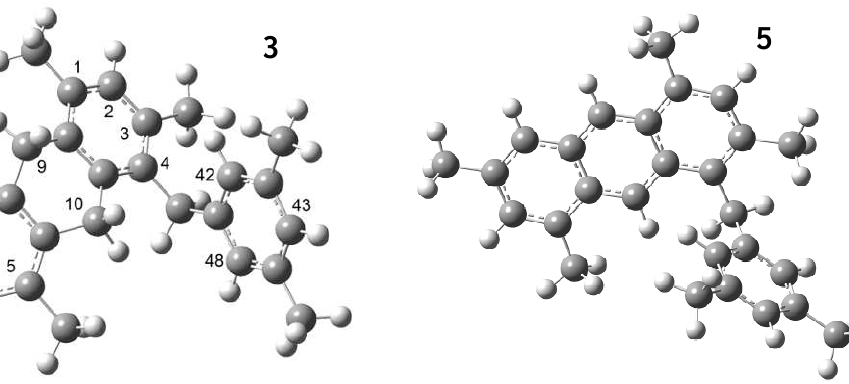
Figure 8. Structures of compounds 3 and 5